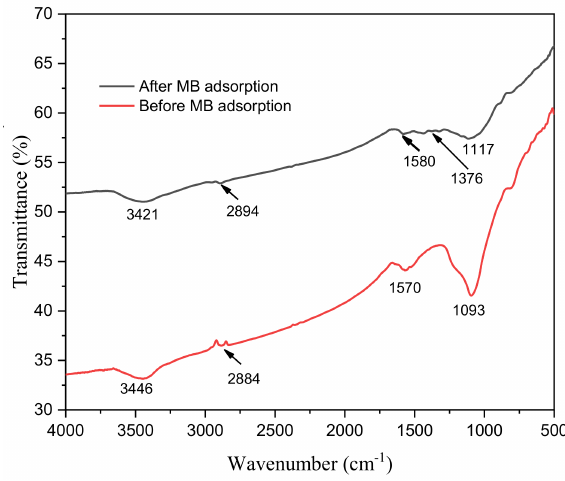
Figure 10. FTIR spectrum of AC700: before and after MB